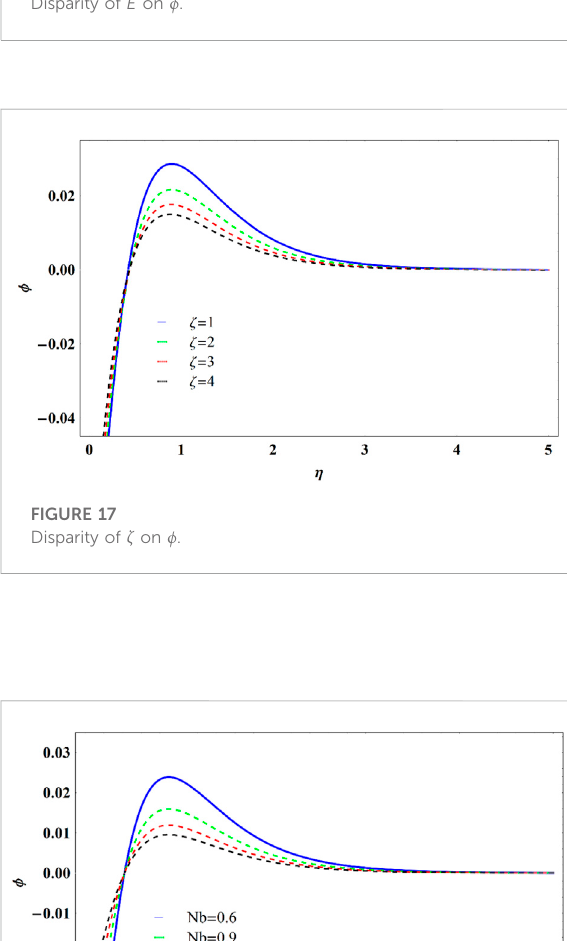
FIGURE 16 Disparity of E on ϕ .